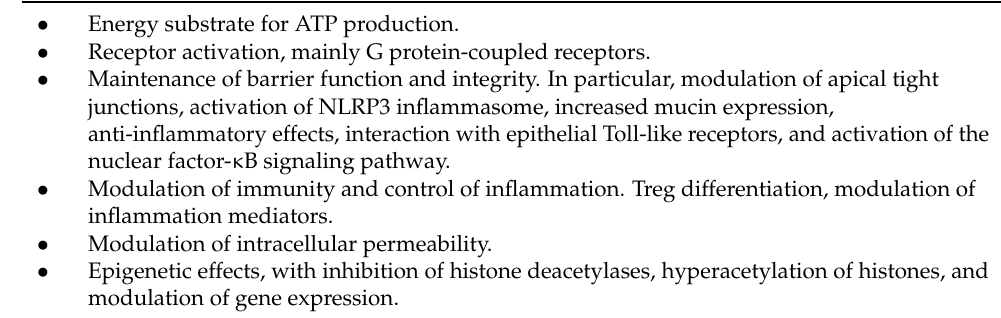
Table 4. Effects of SCFAs on intestinal epithelial cell homeostasis and